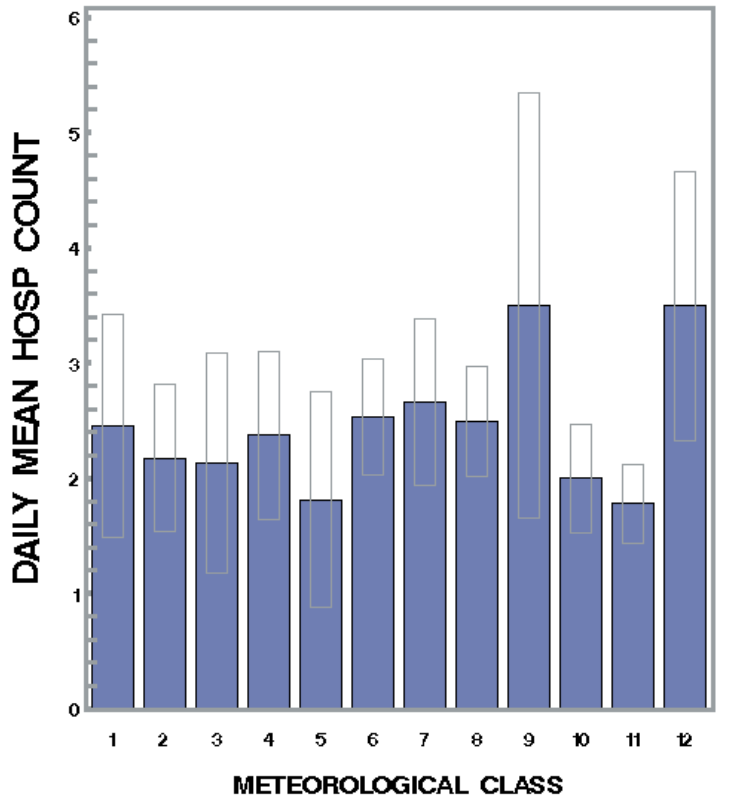
Figure 5. Daily hospitalization during birch pollen season (2006–2017) versus the weather type. Table 2. Correlation between asthma hospitalization and selected environmental factors in Montreal during the pollen season 2006–2008: ( A ) all sectors of Montreal and all weather types; ( B ) discriminated for geographical sectors and weather types (weather types 7,9 and 12 only). W: West Montreal; CN: Center North; CS: Center South. Note. [Birch] refers to birch airborne concentration.